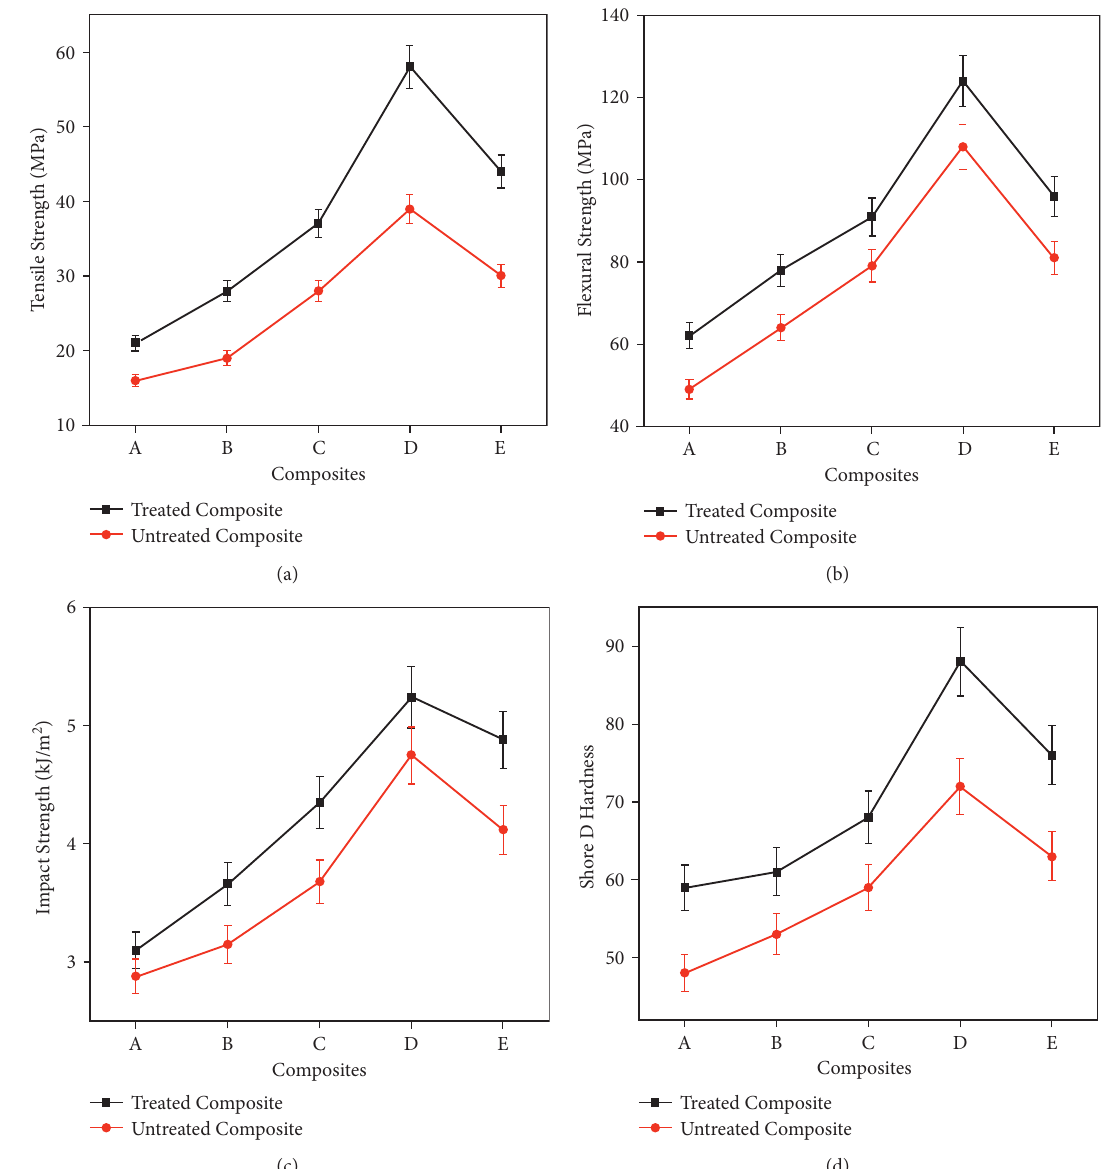
Figure 3: Alkaline-treated and untreated composites: (a) tensile strength, (b) flexural strength, (c) impact strength, and (d) shore D